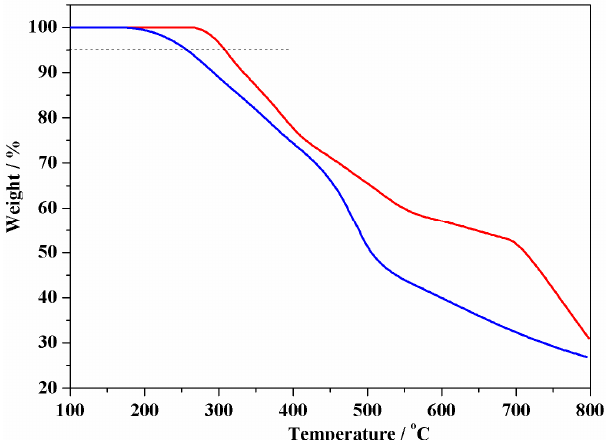
Figure 6. Thermogravimetric analysis (TGA) curves of copolymers Poly( 1 )– b –Poly( DDDPM ) (red line) and Poly( 2 )– b –Poly( DDDPM ) (blue